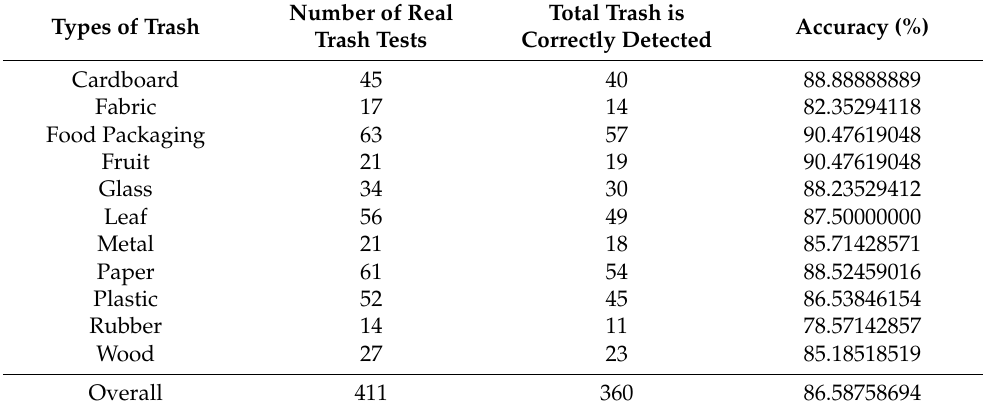
Table 7. The Accuracy of 11 Types of Trash Using a Real-Time Camera with Pre-Trained